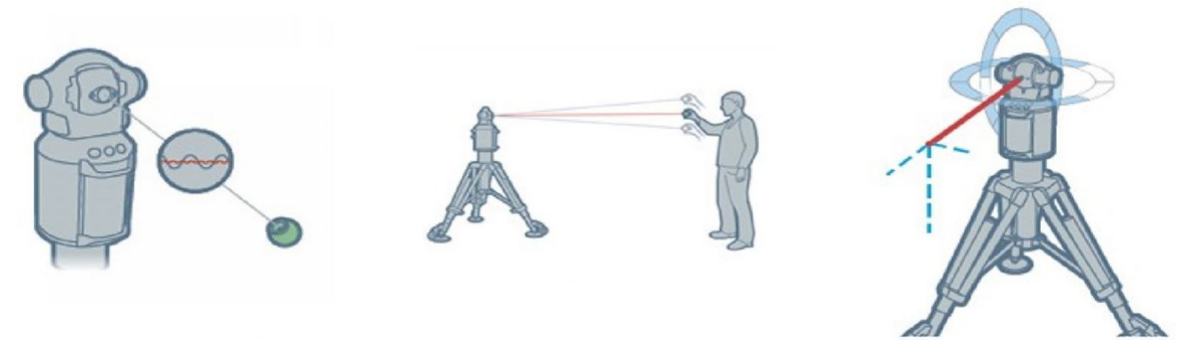
Fig. 1 Laser Tracker Diagram.